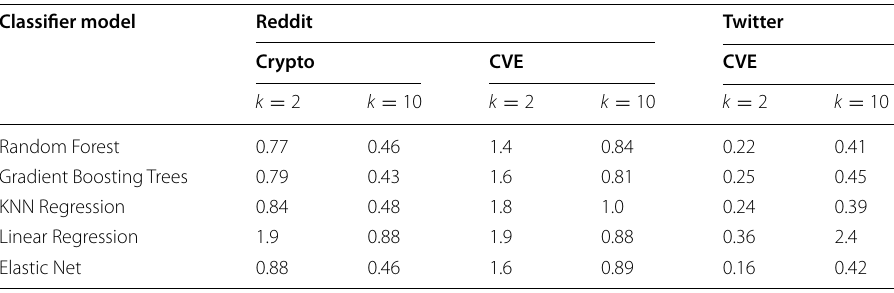
Table 1 Mean Relative Error in the size prediction problem by different regression models across our three datasets (cf. “Datasets” section), for k = 2 and k =